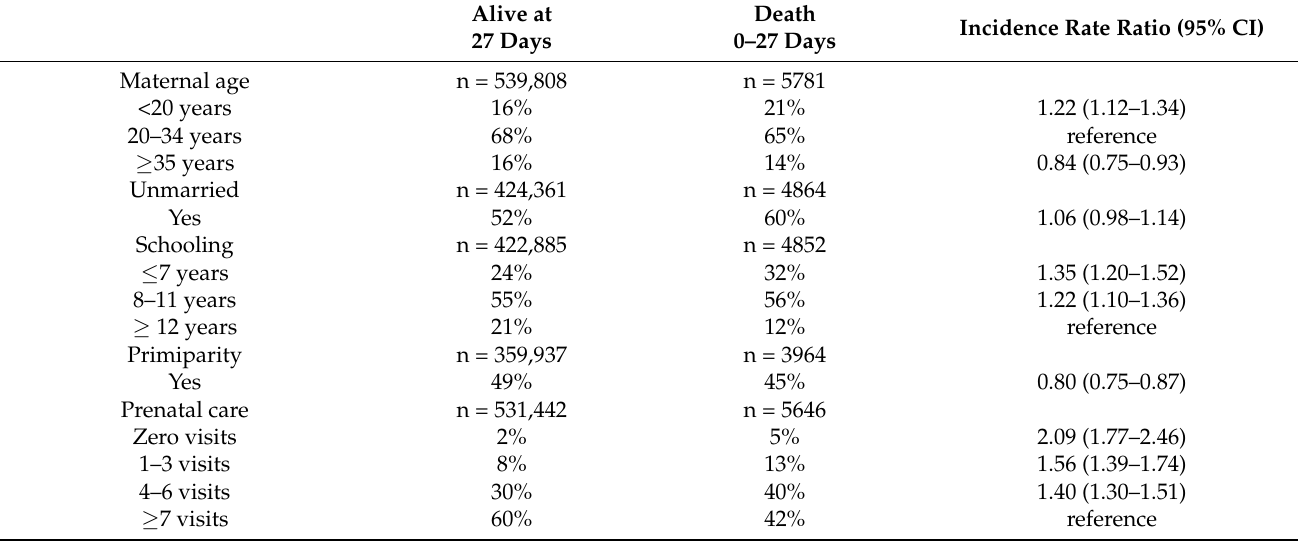
Table 2. Variables associated with neonatal deaths of infants with 32 0/7 –36 6/7 weeks gestation without congenital malformations according to Poisson multivariate regression adjusted by year. S ã o Paulo State, Brazil,